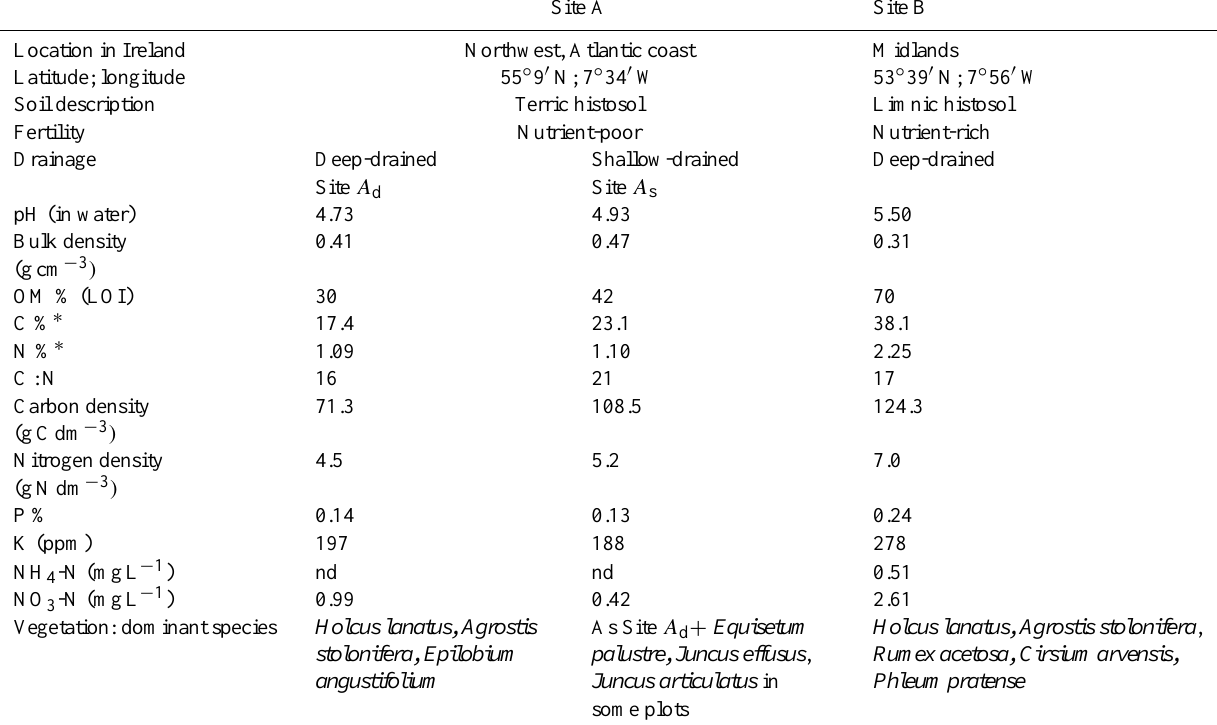
Table 2. Soil and land use characteristics of the research sites.